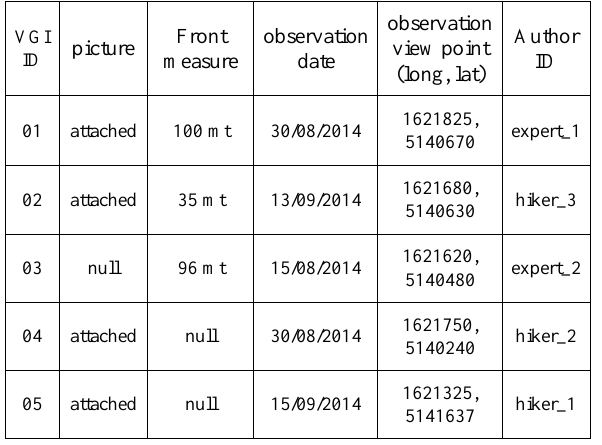
Table 3: list of plausible VGI items used in the simulation.